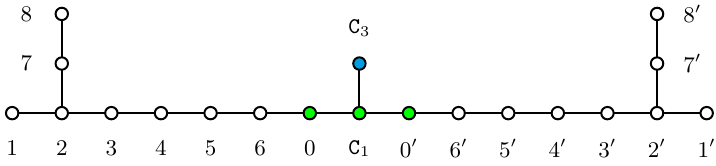
Figure 4. Extended diagram with A 2 = 0 and E = E 2 . This is the simplest example of an extended diagram with non-trivial new